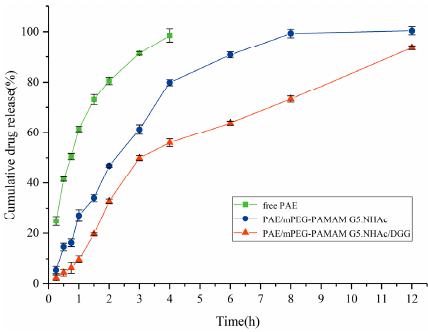
Figure 7. In vitro release profiles of PAE from PAE/mPEG-PAMAM G5.NHAc nanocomposites and PAE/mPEG-PAMAM G5.NHAc/DGG in situ gel in PBS (pH 7.4) at 37 °C. (Error shown as one standard deviation of the mean, n = 3). Table 6. Release mechanism of PAE.